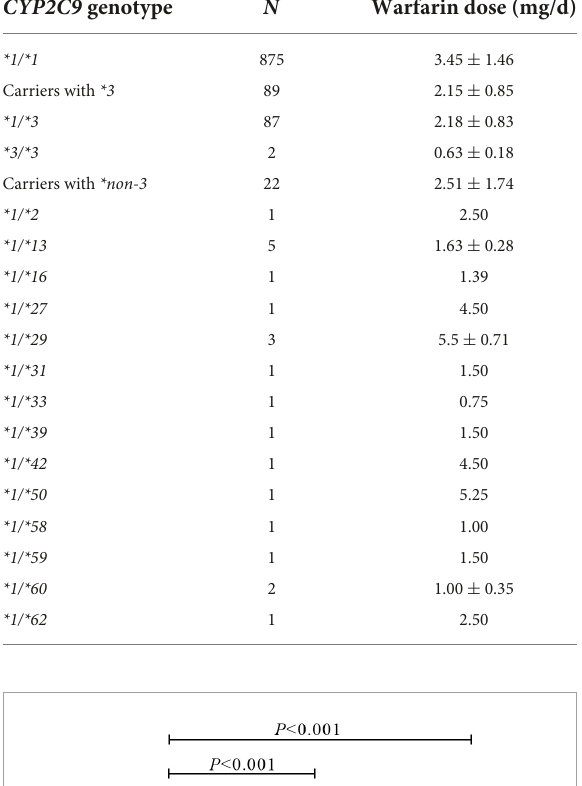
TABLE 4 Stable warfarin doses in different CYP2C9 genotypes carriers.